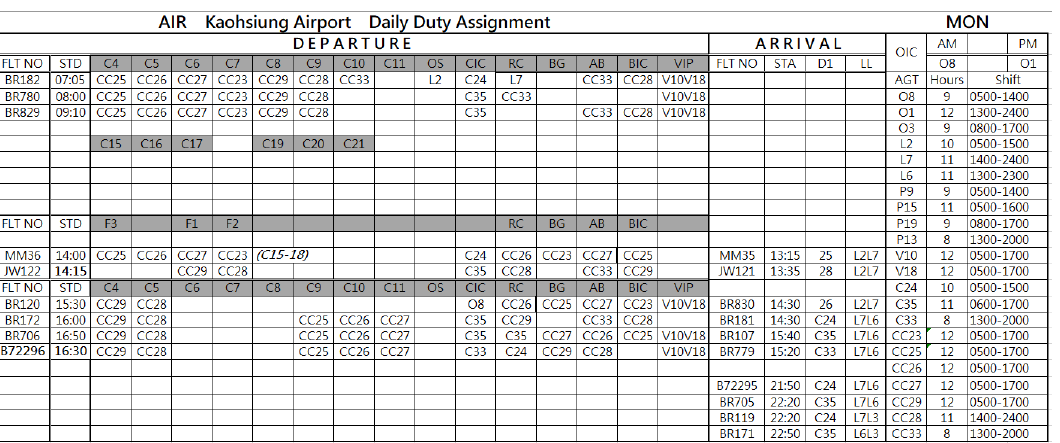
Figure 2. This is a figure, Schemes follow the same formatting. If there are multiple panels, they should Figure 6. Actual results of the job position allocation in a daily be listed as: ( a ) Description of what is contained in the first panel. ( b ) Description of what is contained in the second panel. Figures should be placed in the main text near to the first time they are cited. A caption on a single line should be centered.